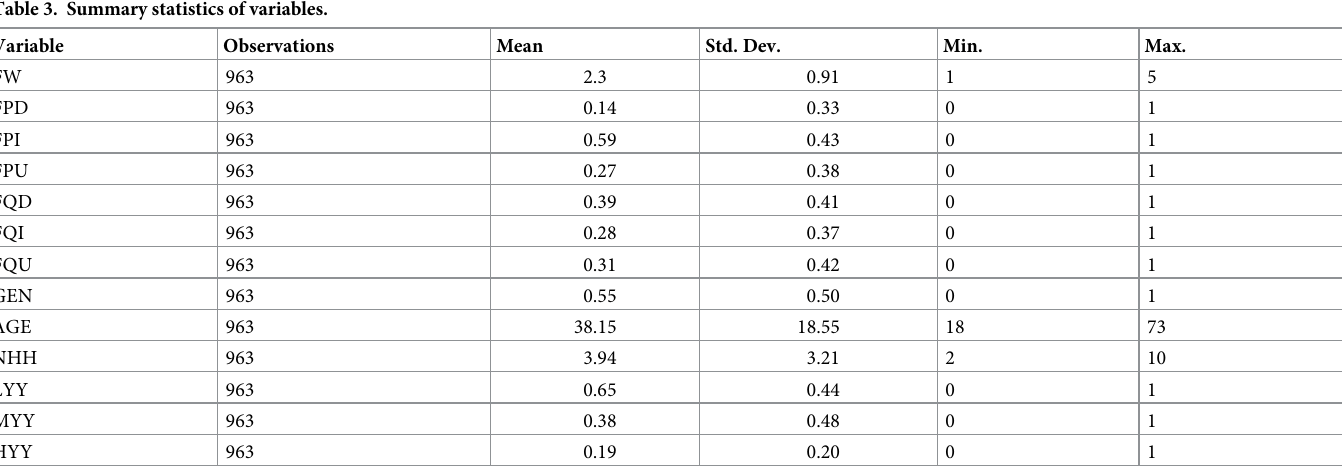
Table 3. Summary statistics of